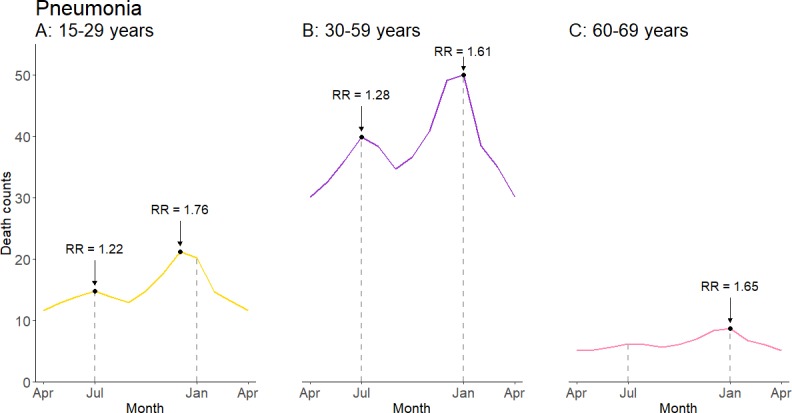
Average seasonal patterns of pneumonia deaths by adult age subset.Each horizontal axis represents an average yearly span from April to April. We determined seasonal patterns using monthly counts of death and modeled using Poisson regression. Rate ratios (RR) were calculated within each disease and were compared to annual minimum mortality in the month of April.10.7554/eLife.46202.011Figure 3—figure supplement 2—source data 1.Monthly predicted values and rate ratios of the average annual pattern of pneumonia mortality, by adult age subset.